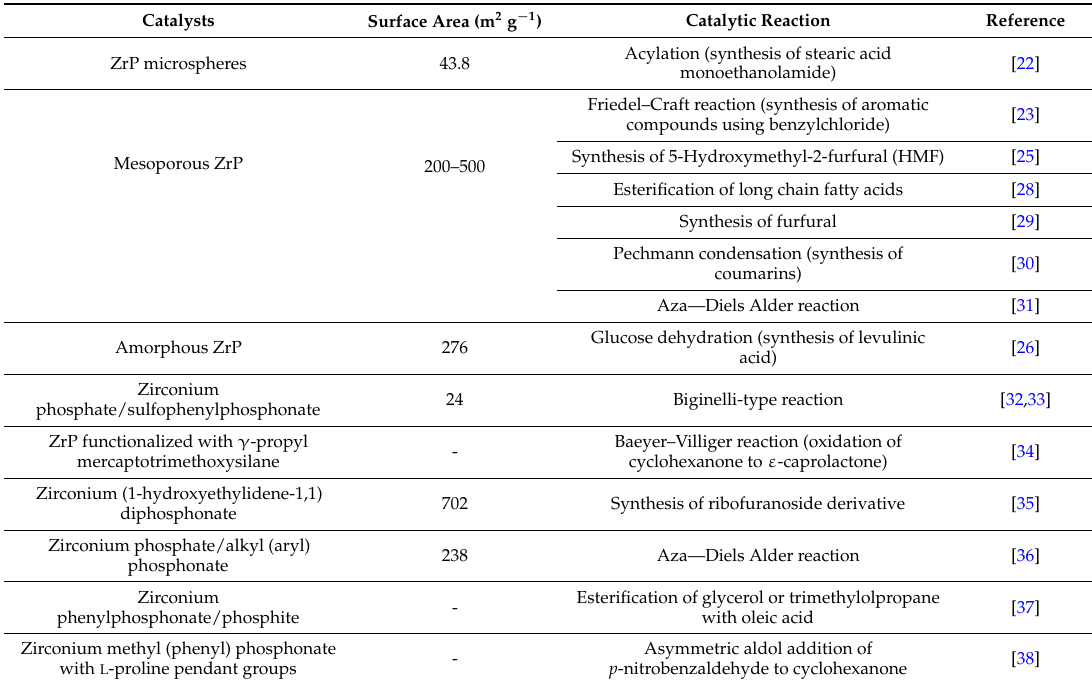
Table 1. Summarizing table on the use of zirconium phosphates and its organic derivatives as heterogeneous catalysts in acid-catalyzed